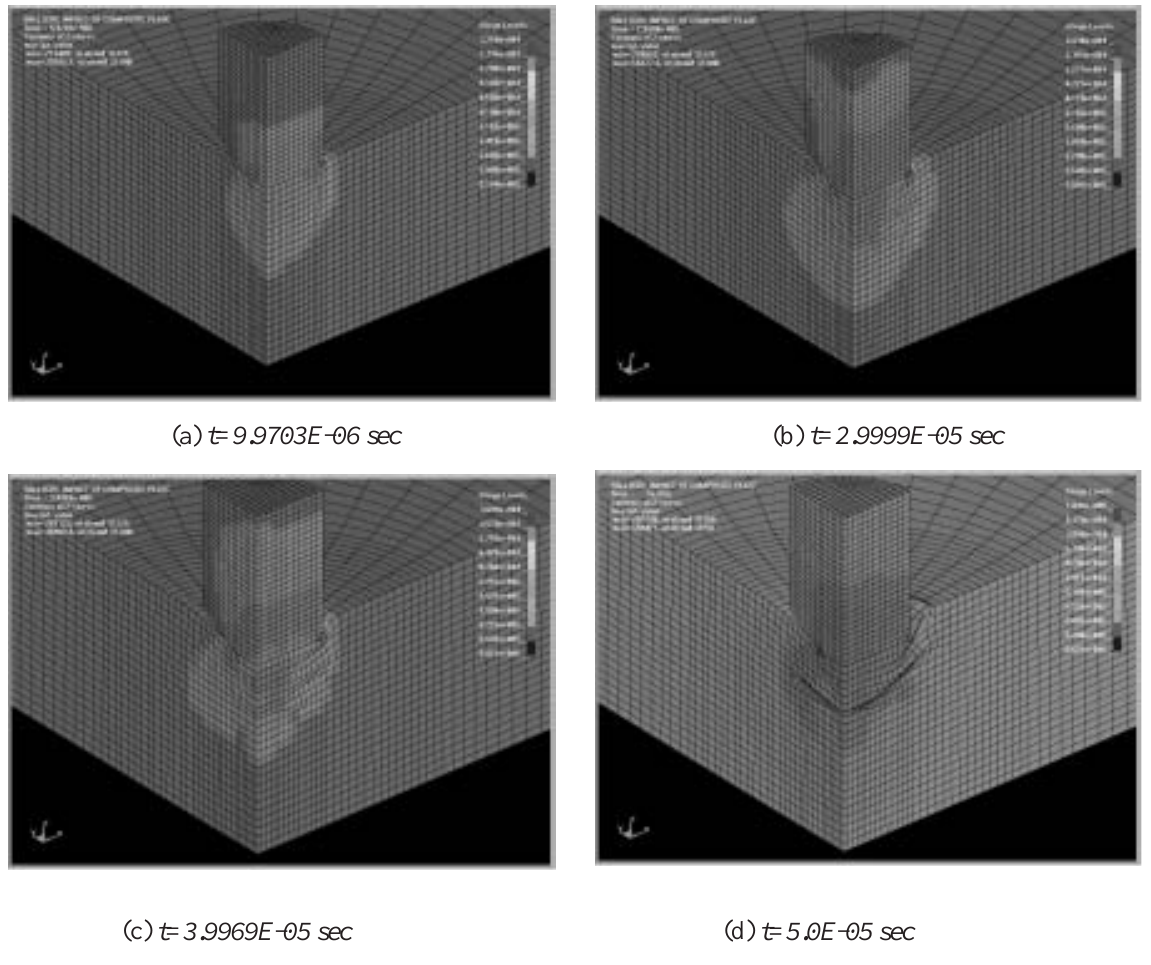
Fig. 7. Deformed shapes and σ zz distribution at t = 9.970e-06 sec, 2.999e-05 sec, 3.997e-05 sec, and 5.0e-05